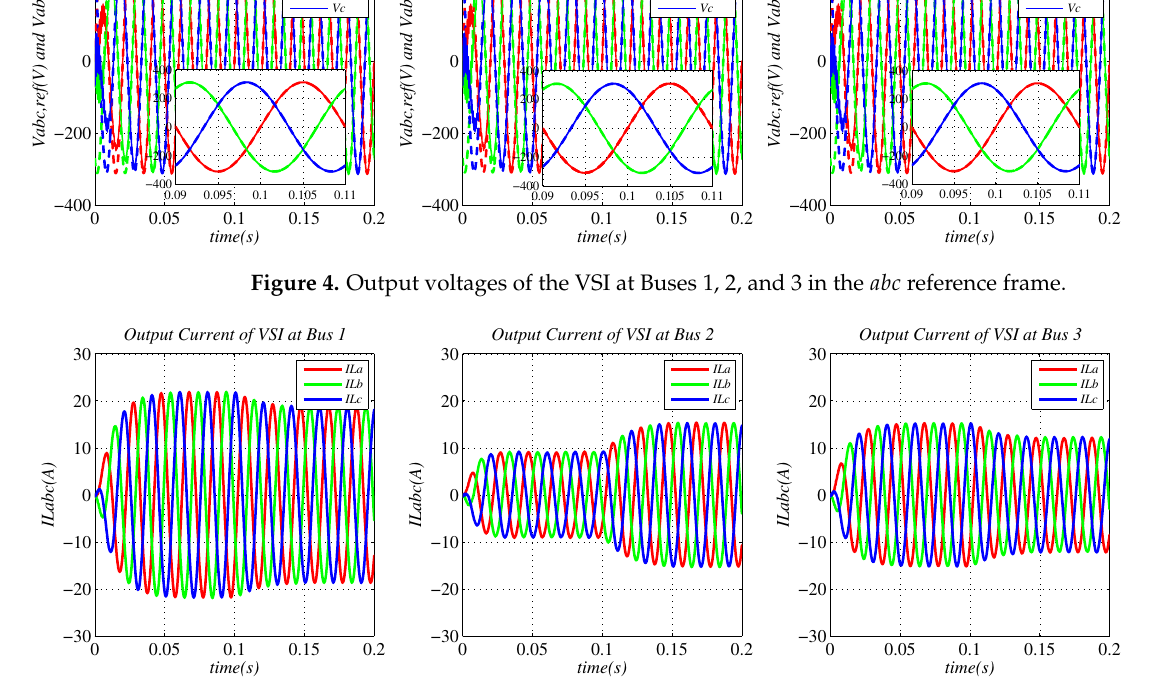
Figure 5. Output current of the VSI at Buses 1, 2, and 3 in the abc reference frame.